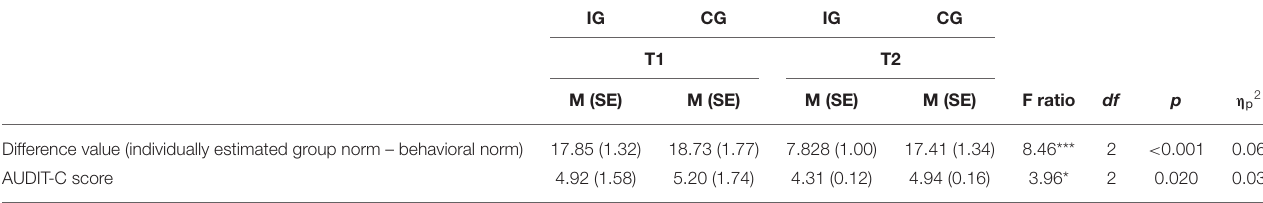
IG CG IG CG T1 T2 M (SE) M (SE) M (SE) M (SE) F ratio df p η p 2